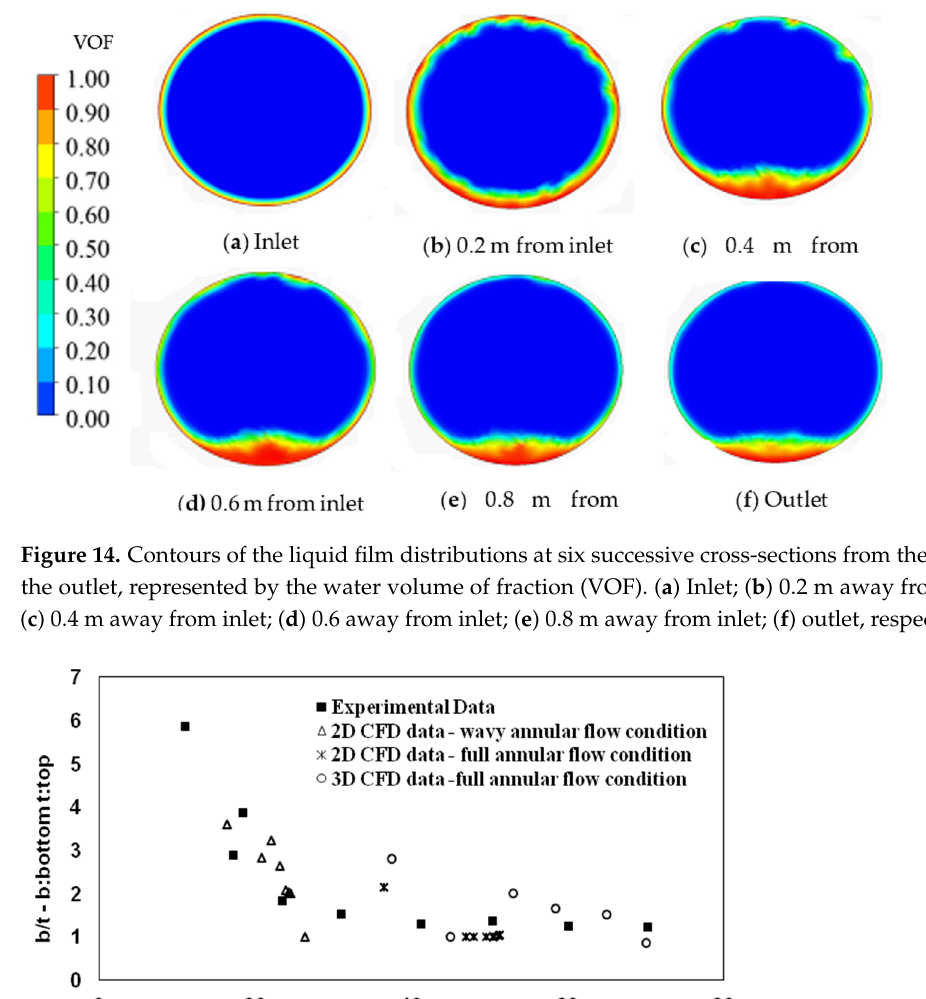
14 of 22 Figure 13. Contours of the liquid film distributions on the pipe walls represented by the water vol- ume of fraction (VOF). Top-right : a vertical 2D mid-plane through the center of a horizontal pipe ( top-right ); Bottom-right : a full 3D liquid film distribution along the pipe wall. Figure 14 gives the CFD predicted liquid film development at six successive cross planes from the inlet to the outlet. It can be seen from Figure 14b that due to the buoyancy effect, the water (liquid) film around the upper part of the pipe wall started to drain with a larger wavy pattern formed. This trend was further enhanced downstream (see Figure